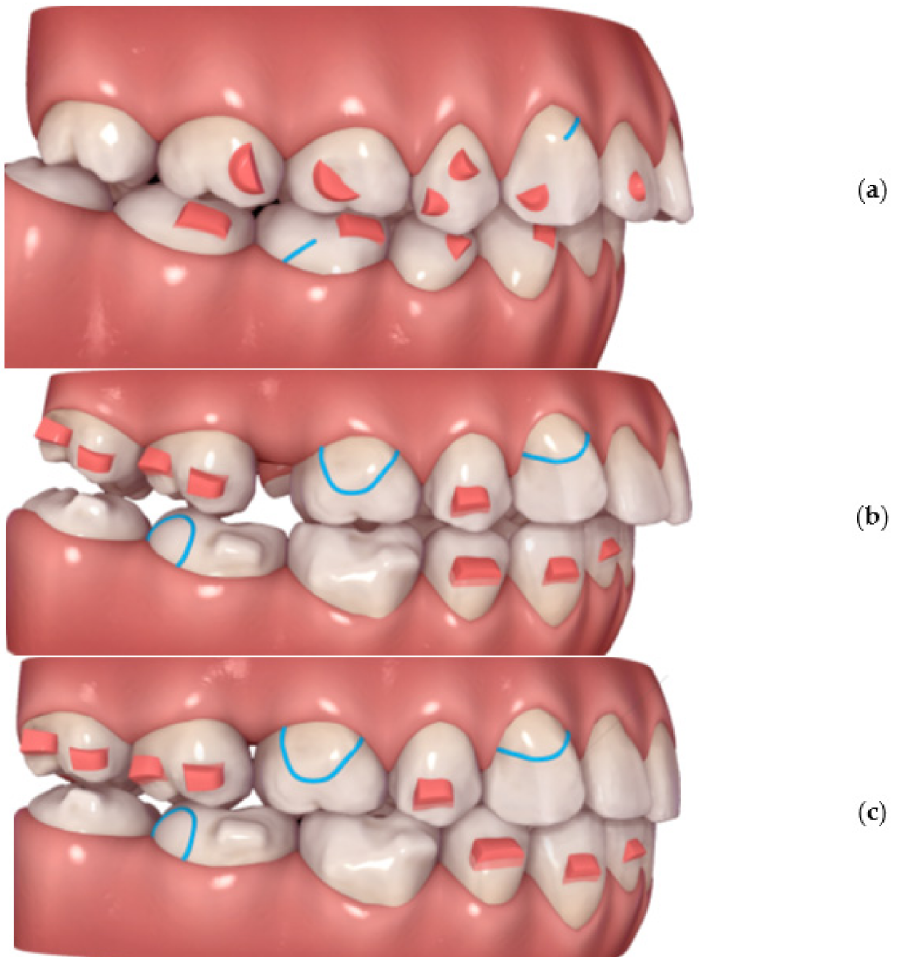
Figure 4. Planning of a personalized unilateral distalizer for upper teeth distalization in a clinical hybrid approach ( a ) initial setup with Class II. elastics in the CAT (Invisalign ® ) to achieve distalization of two terminal molars 18 and 17; ( b ) situation evaluated for a 3D printed personalized distalizer application with a similar biomechanical effect to CMA. The “Button cut-outs” in the aligner on teeth 13 and 16 are intended for 3D printed distalizer custom base fixed adhesion on tooth surface; ( c ) planned clinical target of hybrid treatment with CAT + distalizer with 15%